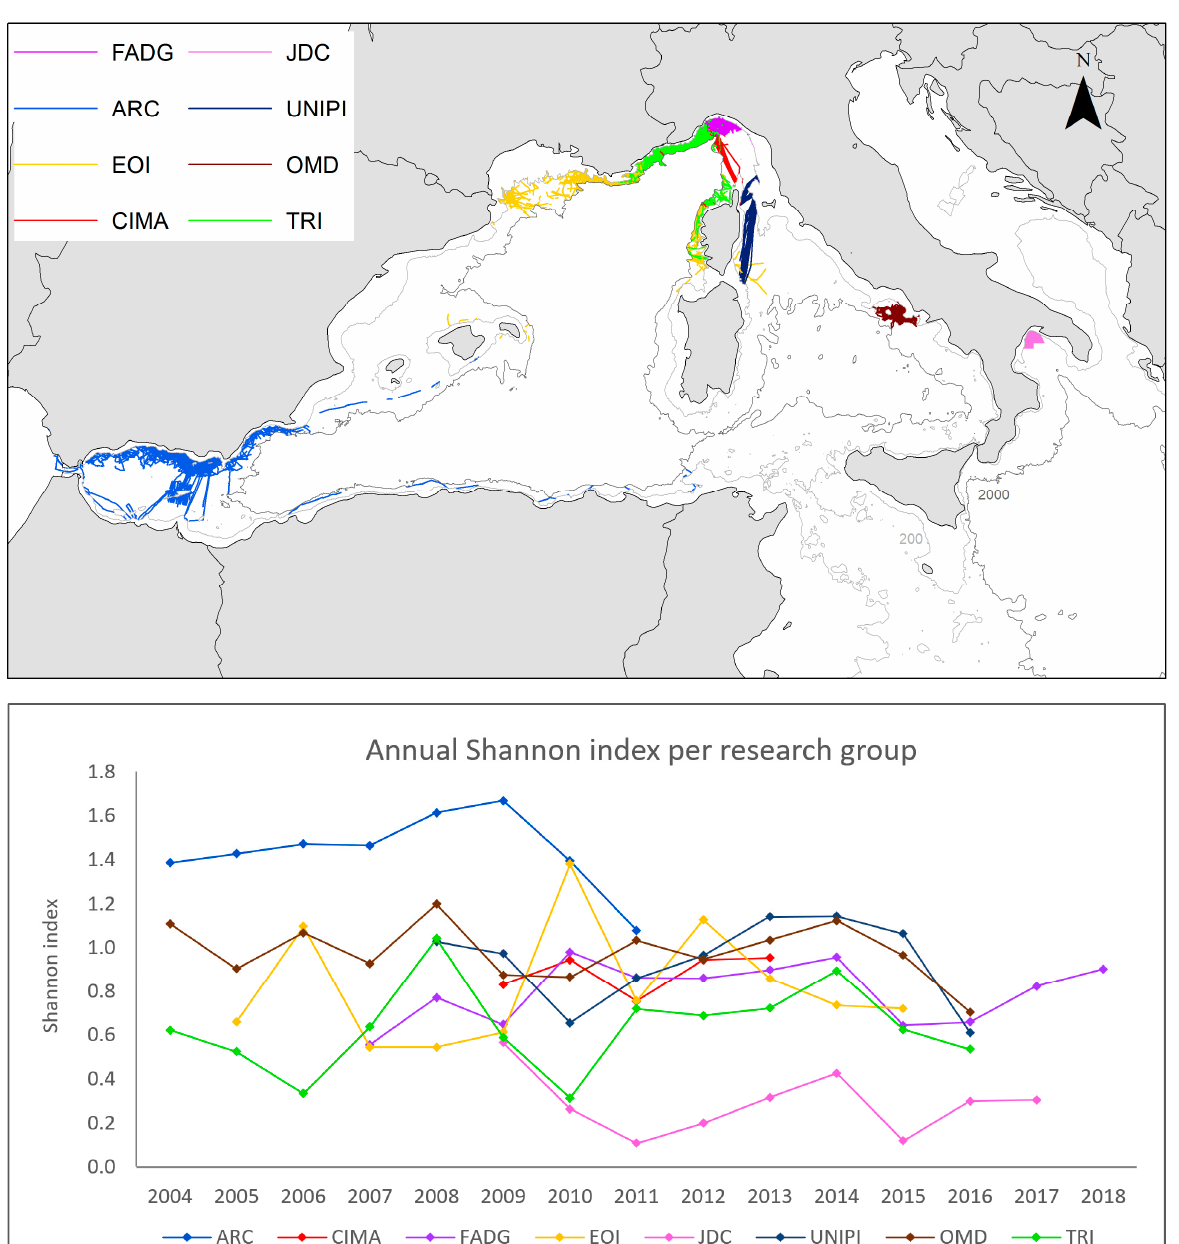
Figure 17. The Shannon index was calculated on an annual basis ( bottom ) in eight different research units, operating in the respective study areas from 2004 to 2018 ( top ). In the datasets analysed, no significant trend was found (Spearman’s rank correlation test, p -value > 0.05). ARC: Alnilam Re-